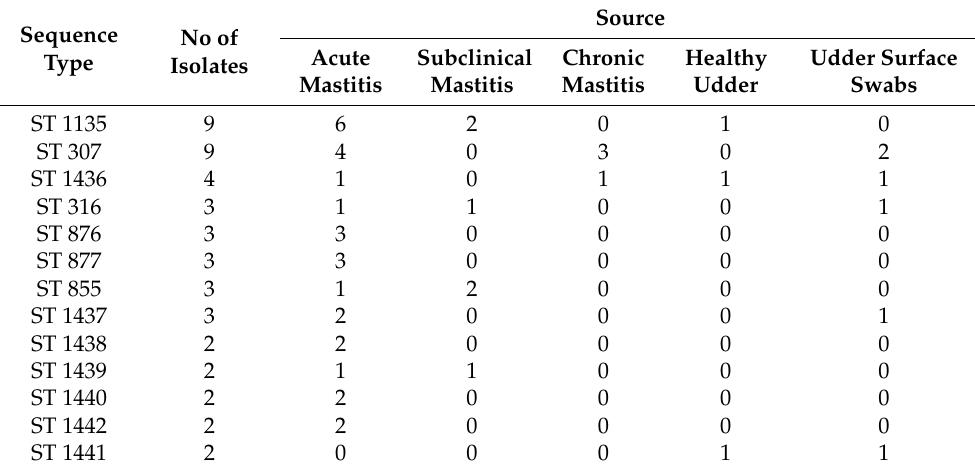
Table 3. Source of isolation of S. uberis sequence types (STs) a